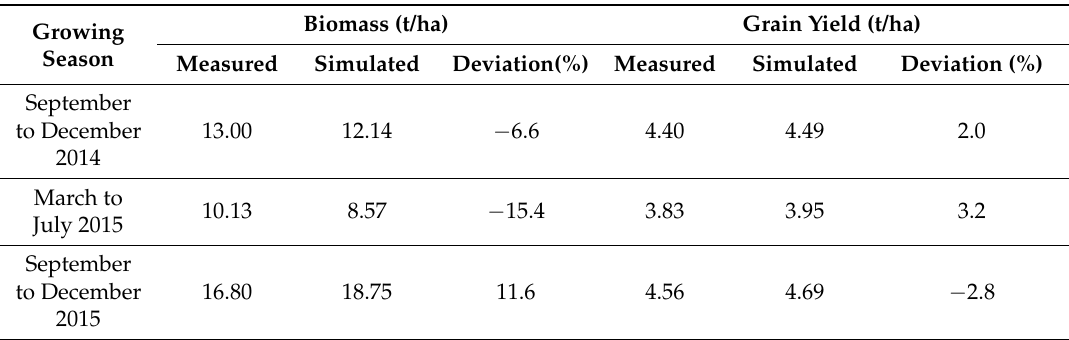
Table 5. Measured vs simulated values of the final aboveground biomass and grain yield.